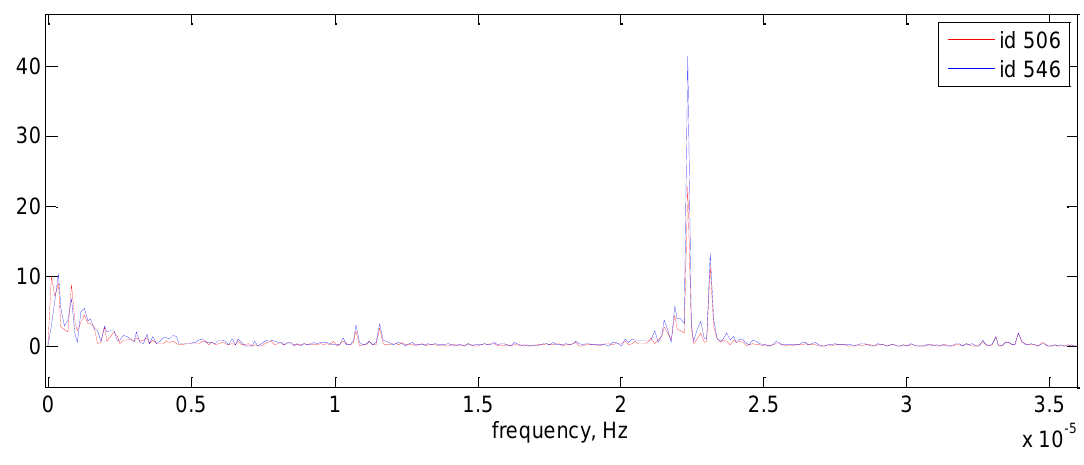
Figure 24. ( a ) Phase shift between two sensors for selected base frequency (12 h) (in radian): red line—phase of AS2 (id 506), blue line—phase of AC4 (id 546), black line—difference between phases. ( b ) Time delay between two sensors for selected base frequency (12 h) (in